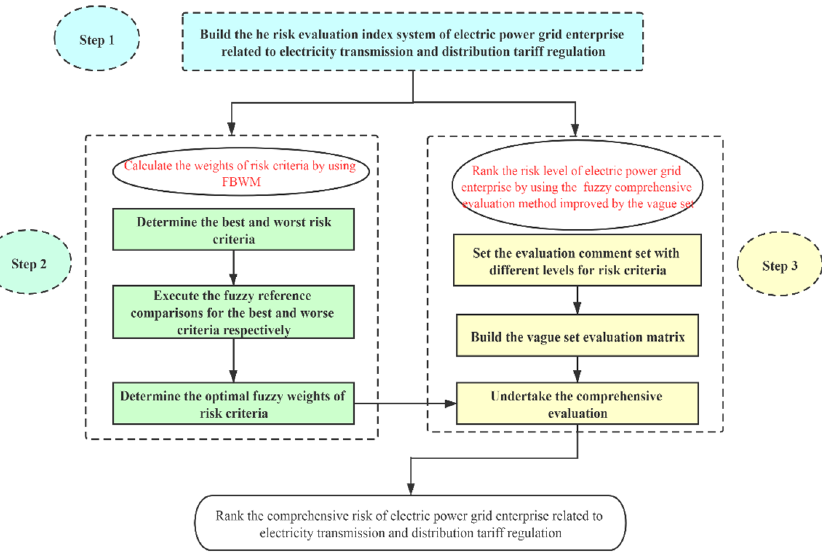
Figure 3. The framework of risk evaluation of electric power grid enterprise related to